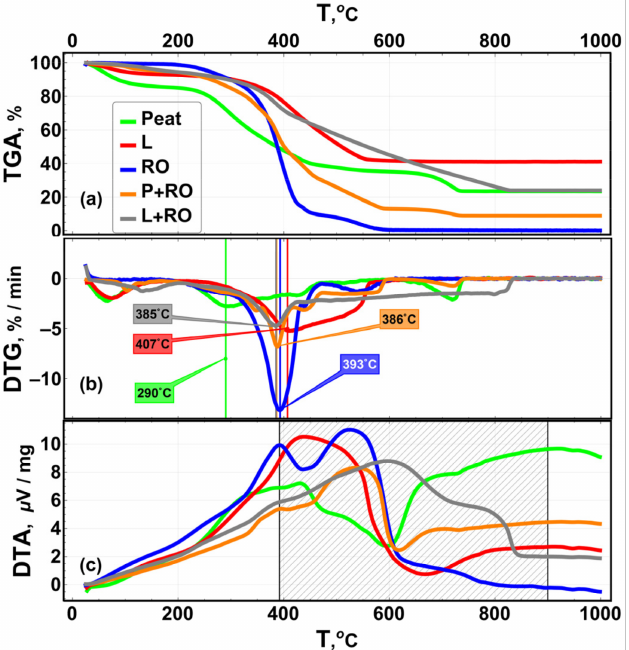
Figure 2. TGA results for thermal decomposition of fuels. TGA dependencies ( a ), the DTG depen- dencies ( b ) and the thermal effect of fuel decomposition ( c ). The shaded area on the plot shows the temperature range where the maximum heat production is recorded for all the